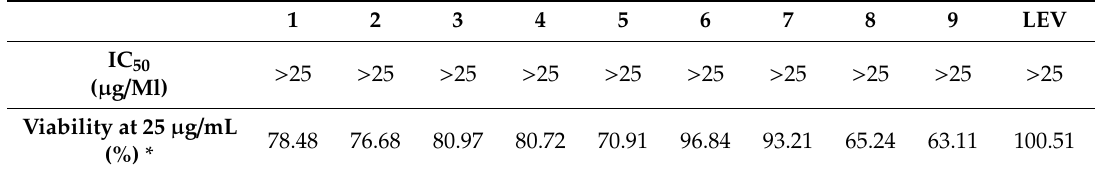
Table 2. Viability of human foreskin fibroblast Hs27 cells (CRL-1634) determined by MTT assay after 24 h of treatment with 4-benzoylthiosemicarbazides ( 1 – 5 ) and 4-arylthiosemicarbazides ( 6 – 9